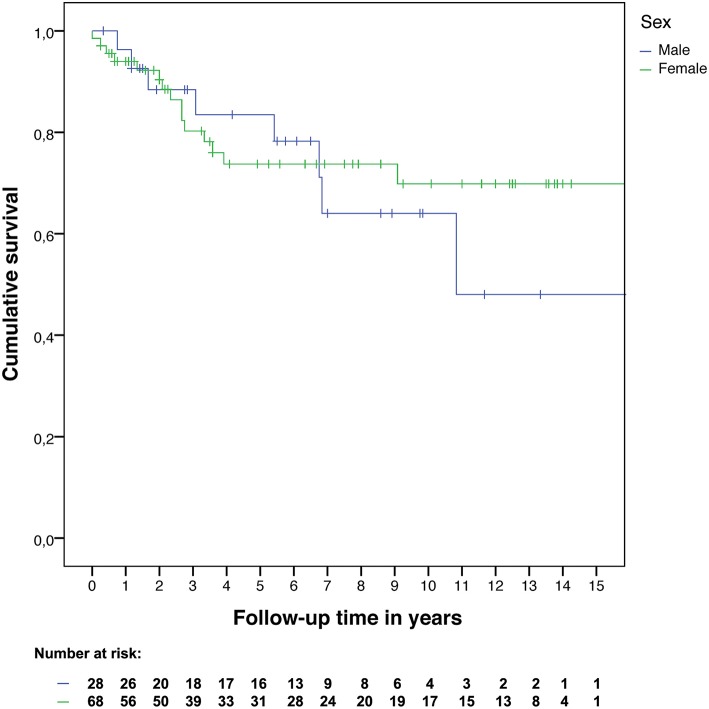
Recurrence-free survival by sex.